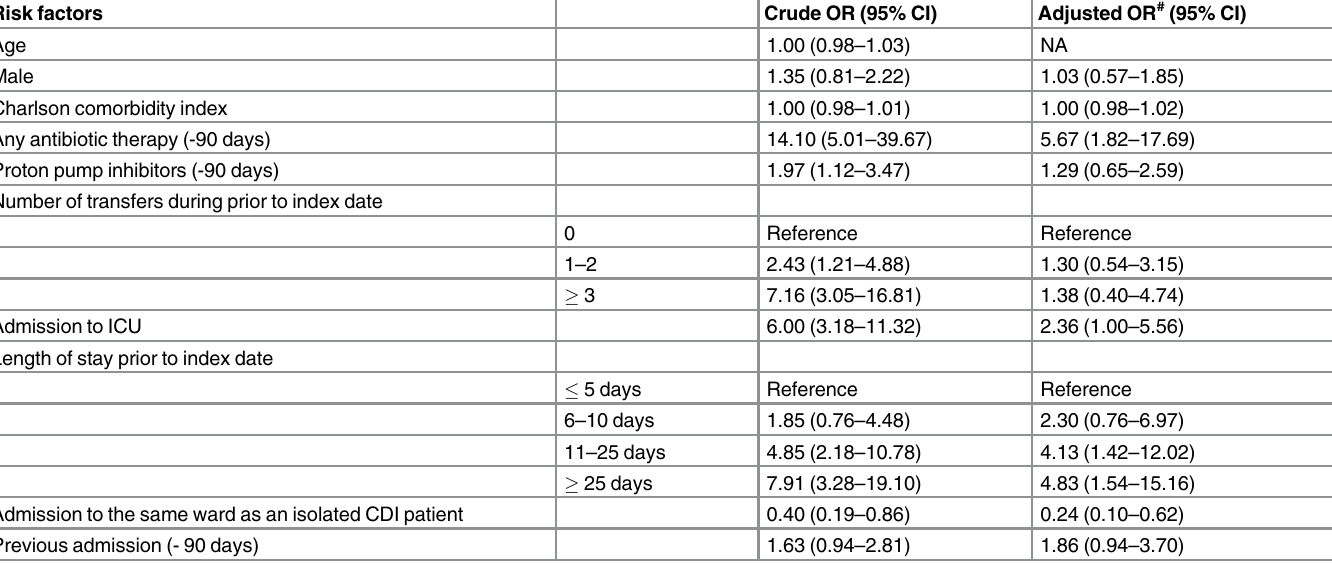
Table 2. Crude and adjusted odds ratios of potential risk factors for the development of CDI ribotype 027 compared to non-CDI control patients.